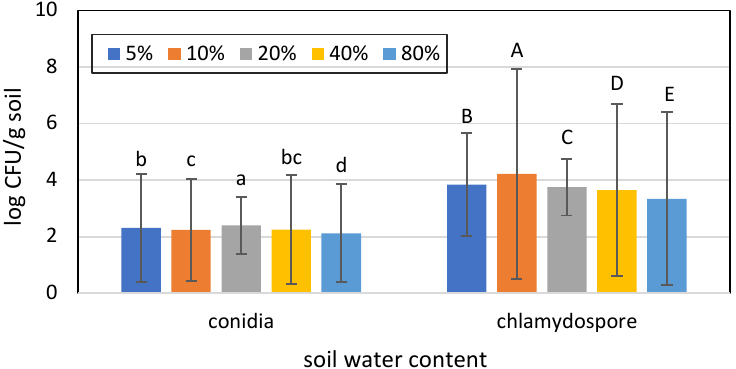
Figure 6. Trichoderma longibrachiatum Tr58 content in conidia- and chlamydospore-amended soils with different moisture contents after 24 months. Lowercase letters and uppercase letters respectively indicate a significant difference between Tr58 contents in different moisture soils amended chlamydospores and conidia, the same letter above the column indicates no significant difference at p < 0.05.